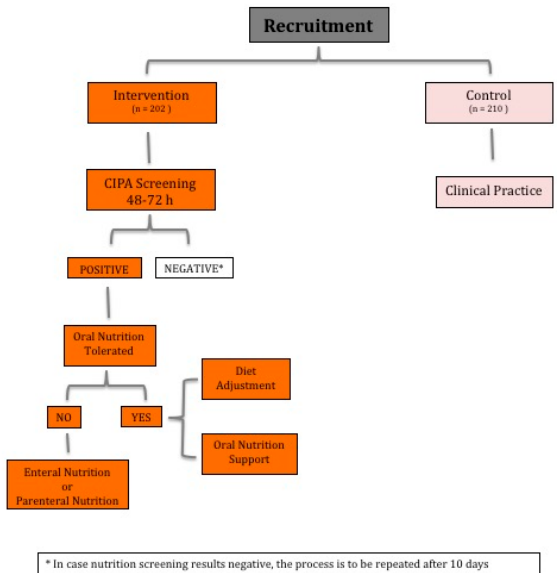
Figure 1. Intervention flow chart. CIPA: Control of Food Intake, Protein, and Anthropometry nutrition screening tool.